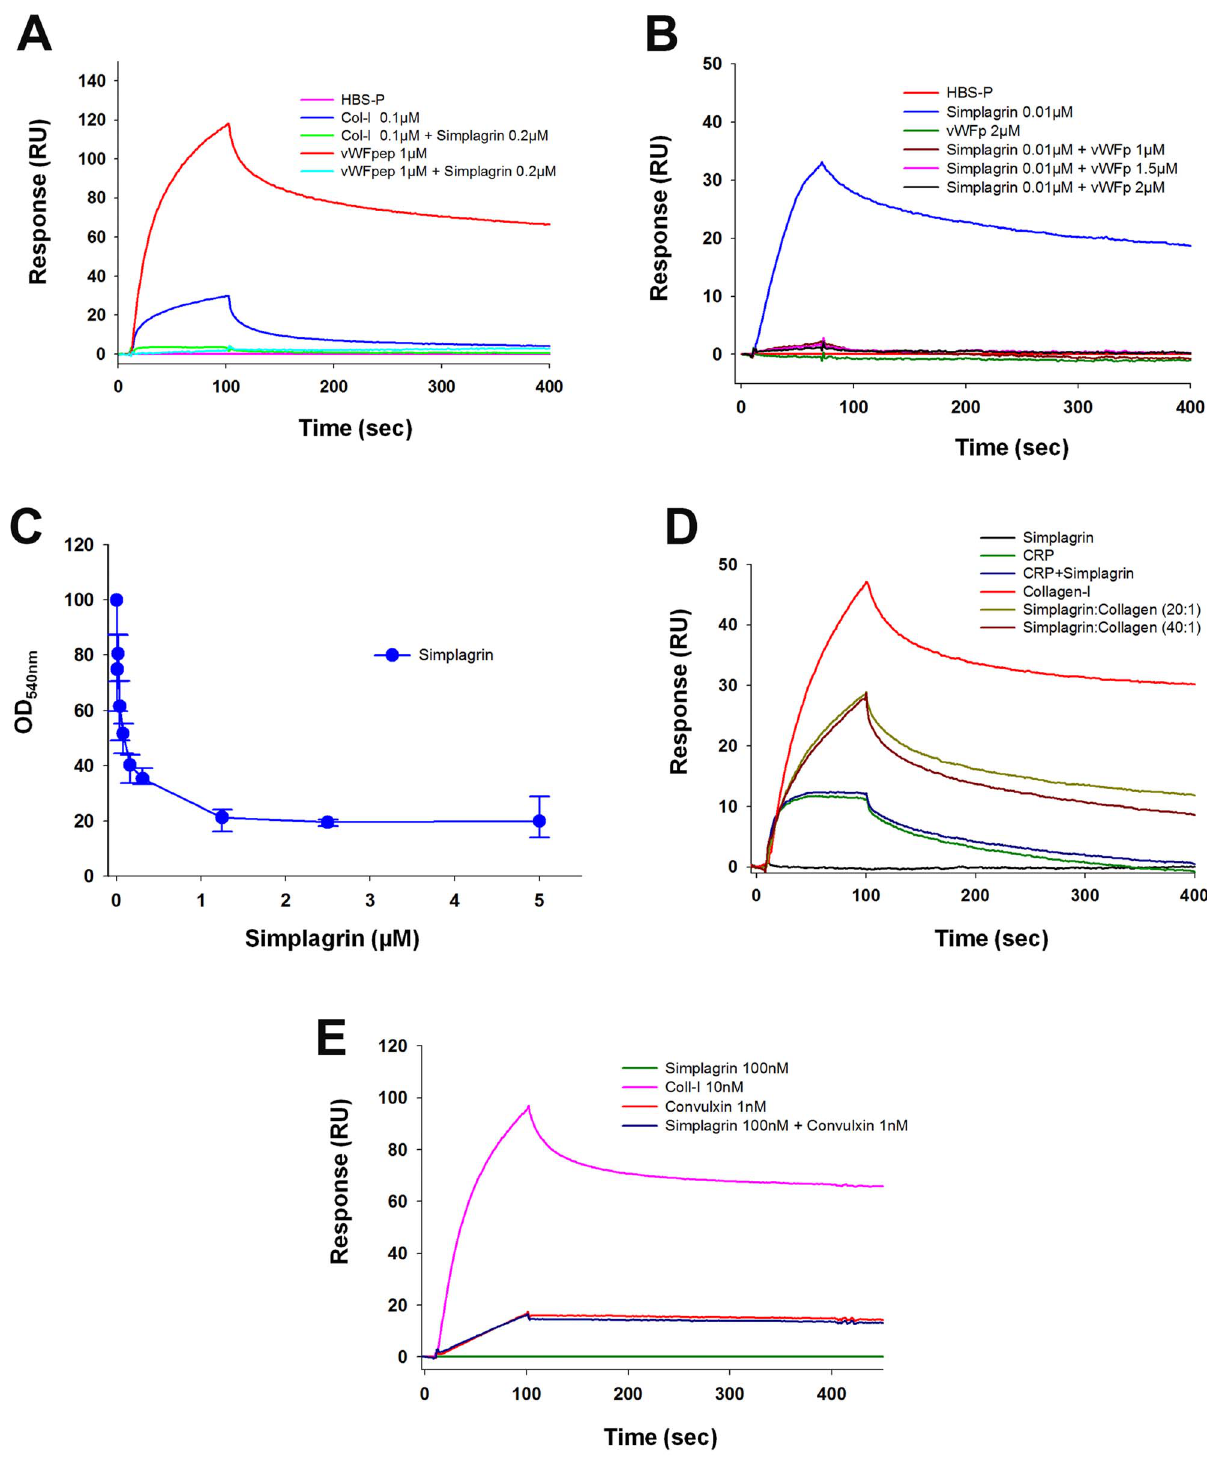
Figure 9. Simplagrin blocks von Willebrand Factor (vWF) interaction to collagen but not GPVI to collagen. (A) In solution competition using surface plasmon resonance (SPR) shows that Simplagrin inhibits interaction of collagen and RGQOGVMGF peptide on immobilized vWF. Collagen type I (0.1 m M) or RGQOGVMGF peptide (1 m M) in the presence or absence of Simplagrin (0.2 m M) were flowed over immobilized vWF. No detectable Simplagrin-vWF binding was observed. (B) Preincubation Simplagrin with saturating concentrations of RGQOGVMGF peptide abrogates Simplagrin-collagen interaction in SPR experiments. (C) Solid-phase assay showing that Simplagrin blocks, in a dose-response manner, collagen vWF interaction. (D) Simplagrin partially blocks GPVI-collagen interaction. SPR in solution competition shows that preincubation of collagen or CRP with Simplagrin at 1:20 or 1:40 molar ratios only reduces the response binding of collagen to GPVI approximately 60%; however, Simplagrin fails to block CRP-GPVI interaction. This can be explained by steric hindrance of Simplagrin binding to RGQOGVMGF sequence in collagen. (E) Control experiment showing that Simplagrin does not affect convulxin-GPVI interaction. All SPR experiments were carried out in triplicate. doi:10.1371/journal.pntd.0002947.g009 PLOS Neglected Tropical Diseases |